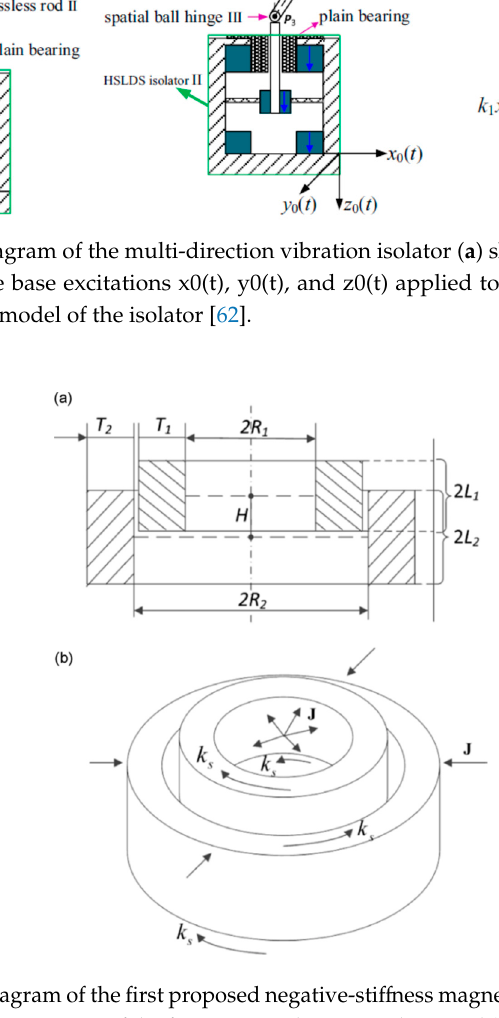
Figure 11. The second proposed NSMS Stewart platform vibration isolator prototype [66].